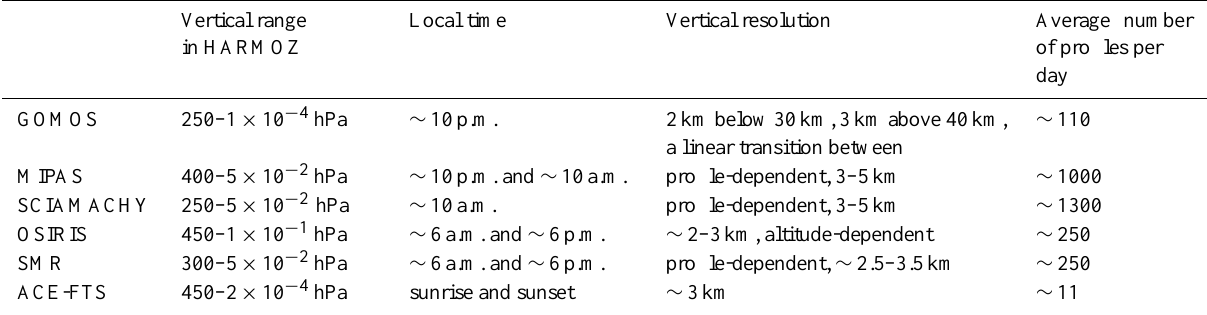
Table 1. General information about the HARMOZ data sets. Vertical range Local time Vertical